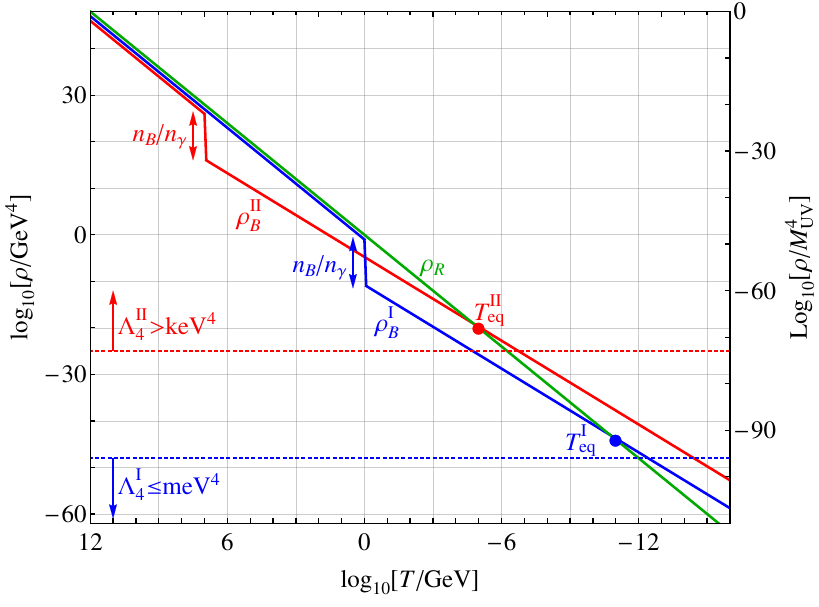
Figure 9 . The cosmological evolution of energy densities (cid:26) as a function of temperature T with M UV = 10 12 GeV. The green line shows the radiation energy density decreasing as T 4 . The blue and red solid lines show the energy densities of the lightest baryonic state (cid:26) I,II in a typical B Class I ( v = v (cid:3) ) and Class II ( v = M UV ) vacuum, respectively. The baryonic energy density drops by a factor of n B =n (cid:13) when the temperature falls below the mass of the lightest baryon. At this point, the anti-baryons annihilate away with most of the baryons until only the asymmetric component remains, which is nonrelativistic and redshifts as T 3 . The blue and red dots indicate matter-radiation equality and their corresponding temperatures T I,II in both scenarios. The blue eq and red dotted lines show the critical cosmological constant (cid:3) 4 for which galaxies can just form, and is di(cid:11)erent in Class I and II. For our mechanism to work, the smallest CC in Class I vacua (cid:3) I 4 should be smaller than the critical value of meV 4 , while (cid:3) II should be larger than the critical value 4 of keV 4 in Class